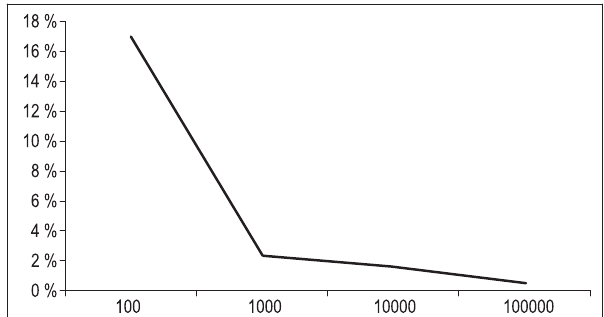
Fig 1. Coeffi cients of variations for different notions of “l” variable